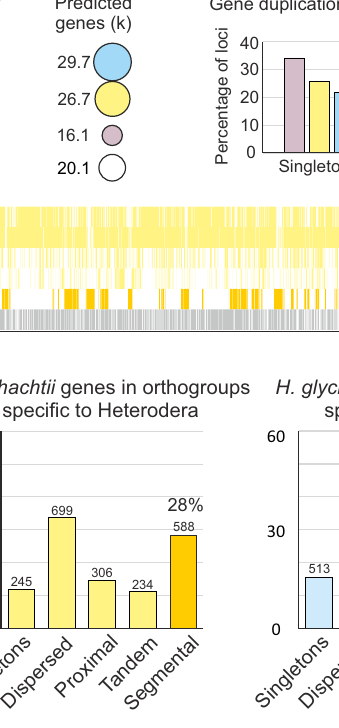
duplication plots, from left to right: all H. schachtii genes, H. schachtii genes in orthologous gene clusters categories speci fi c to Heterodera, H. glycines genes in orthologousgeneclusterscategoriesspeci fi ctoHeterodera,and H.schachtii genes in orthologous gene clusters categories speci fi c to H. schachtii . Numbers above each bar represent the number of genes per